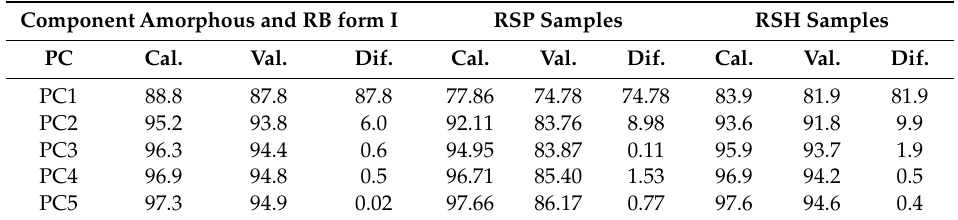
Table 2. Cumulative percentage of variances of PCA based on NIR-PXRD multi-dataset. Component Amorphous and RB form I RSP Samples RSH Samples PC